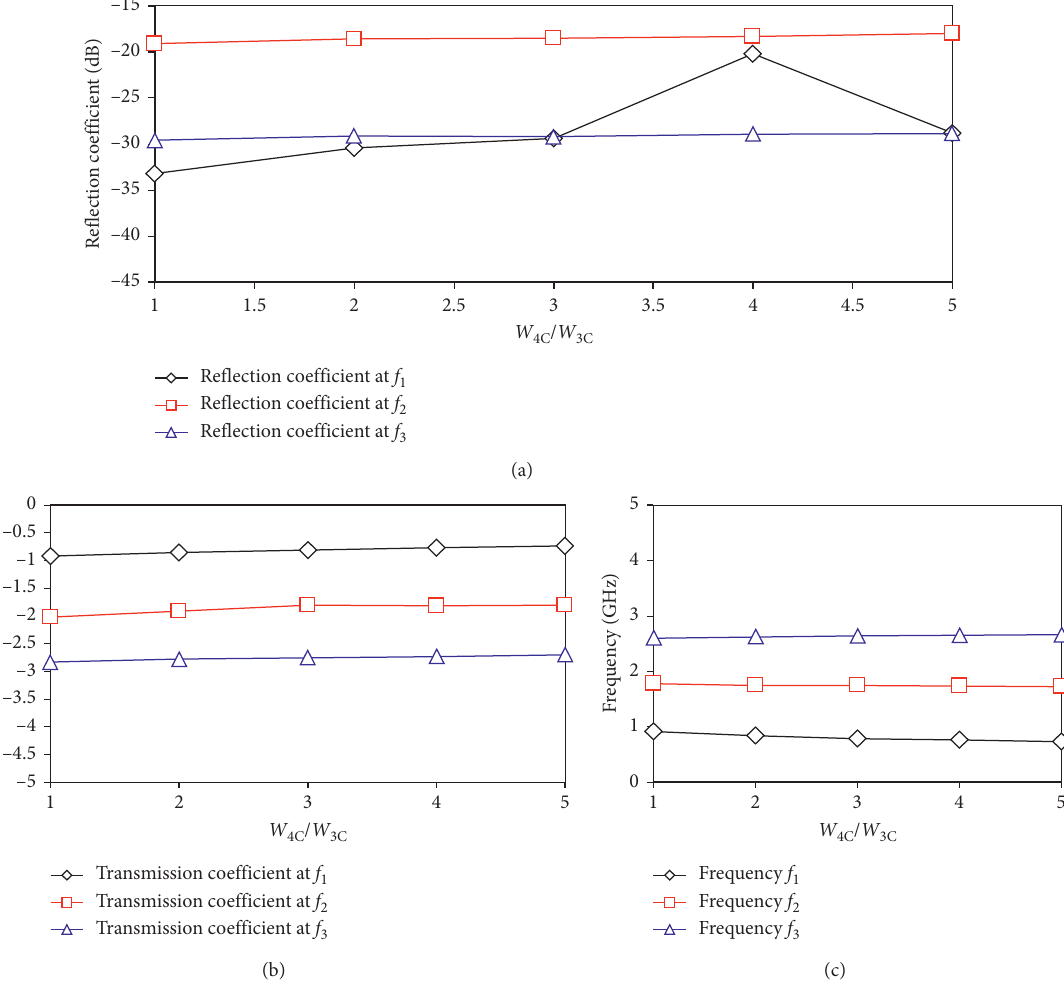
Figure 10: (a) The reflection coefficients, (b) transmission coefficients, and (c) resonant frequencies of the MW-BPF using an FQC-SSIR with varied W 4C / W 3C values.